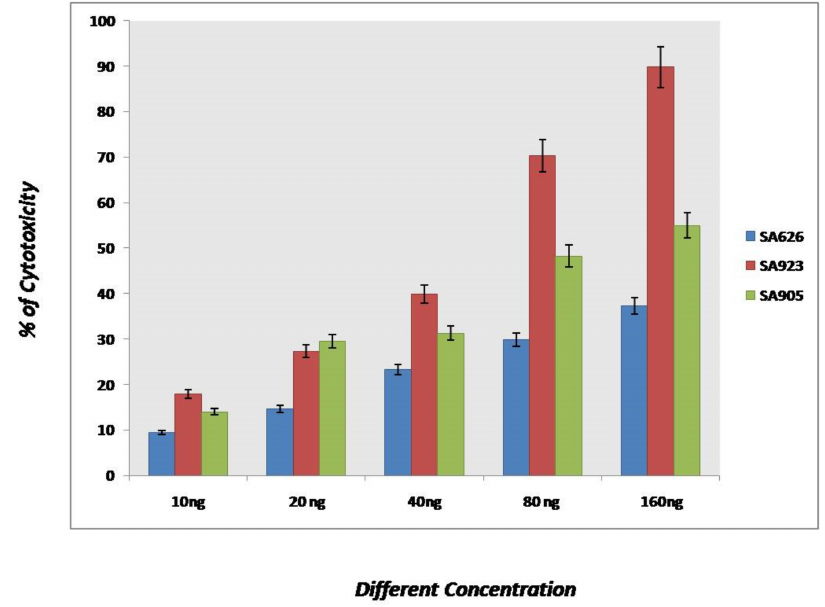
Figure 5. MTT assay for cytotoxicity (%) of peptide in noncancerous 3T3